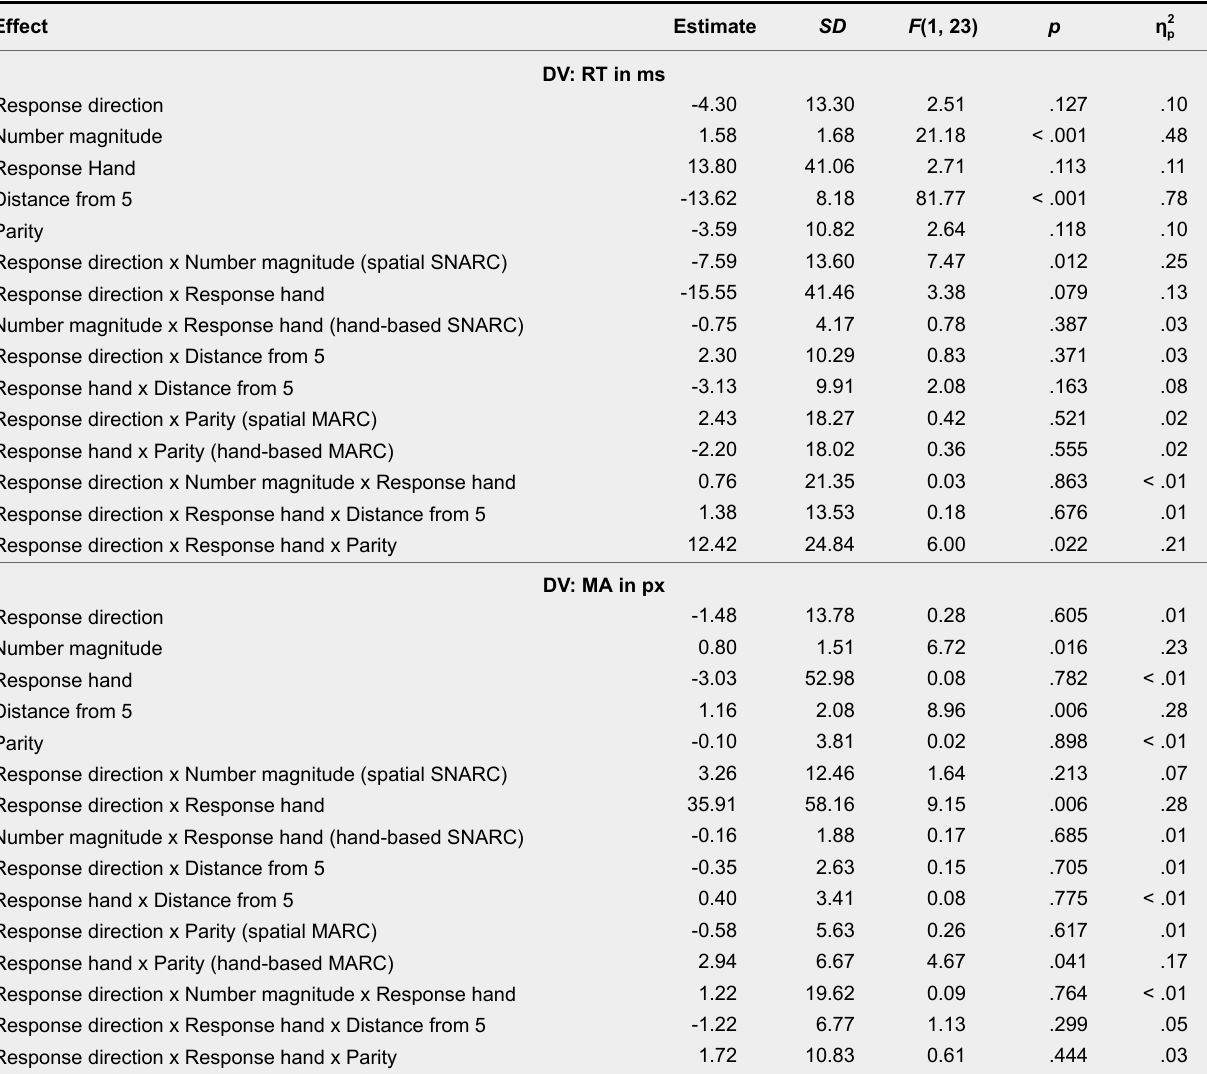
Estimated Effects and Statistics for Dependent Variables of the Magnitude Classification